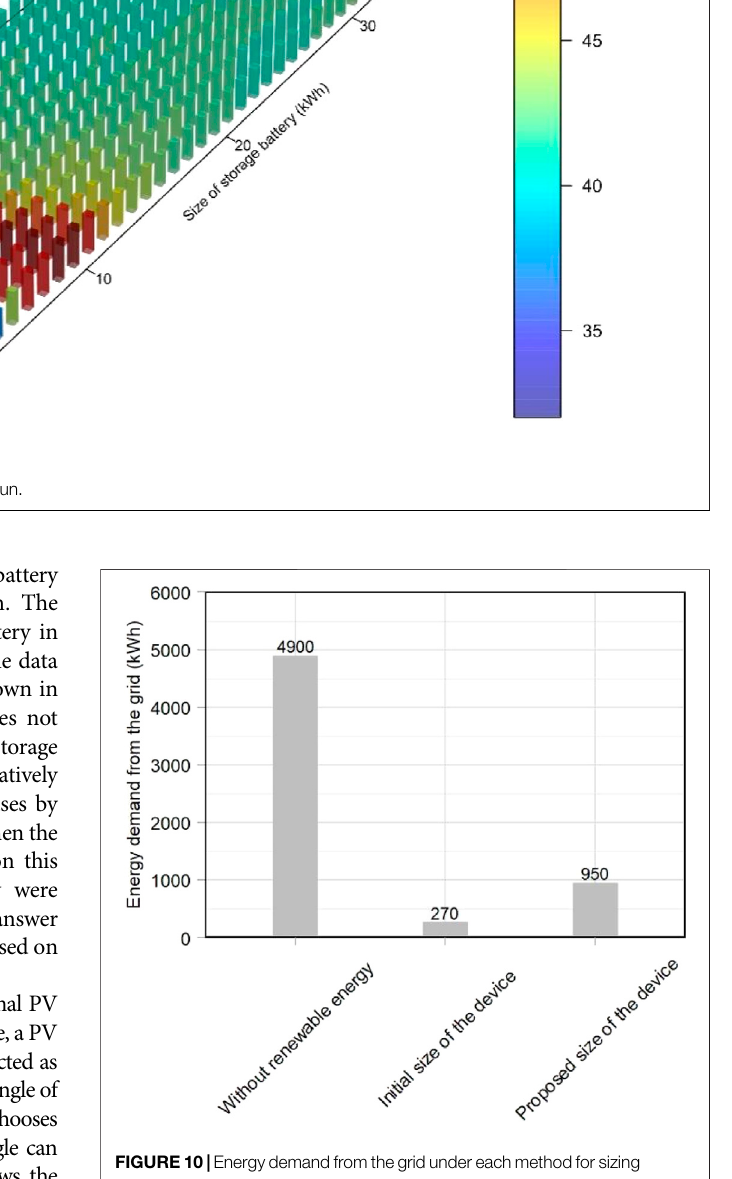
FIGURE10| Energydemandfromthegridundereachmethodforsizing the